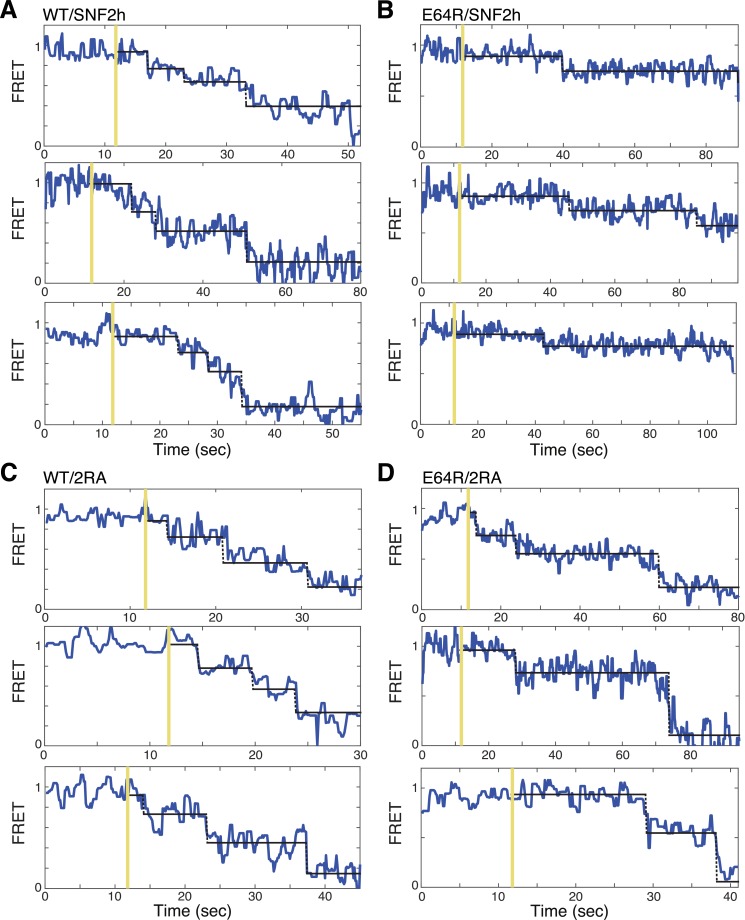
Additional example traces of SNF2h or SNF2h/2RA remodeling single nucleosomes, plotted as in Figure 3C.